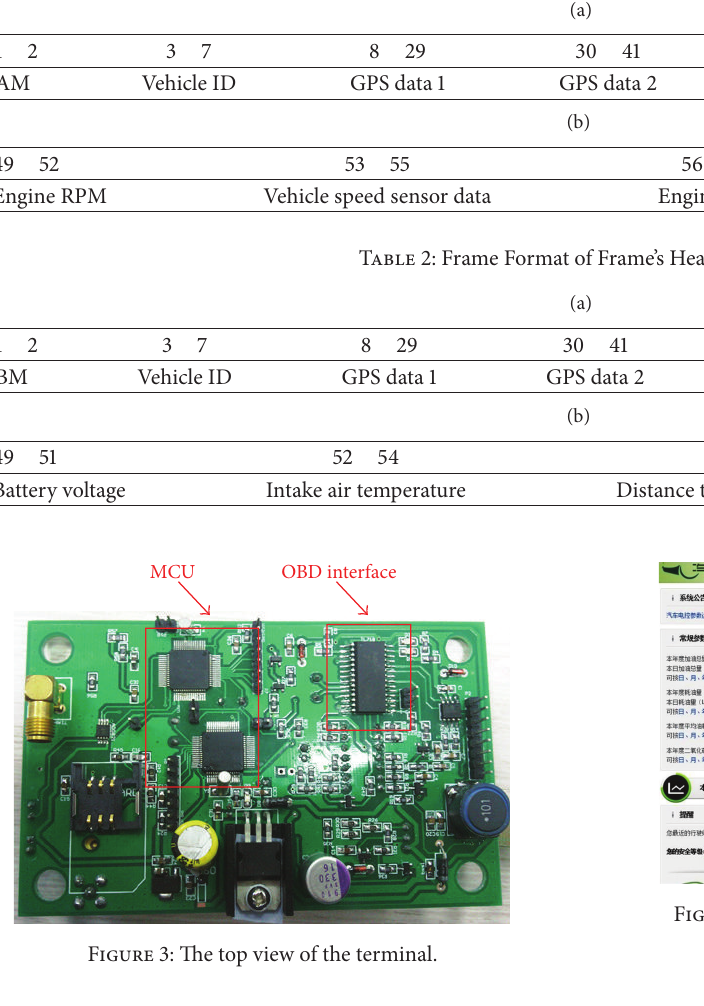
Table 1: Frame Format of Frame’s Header is “AM”.